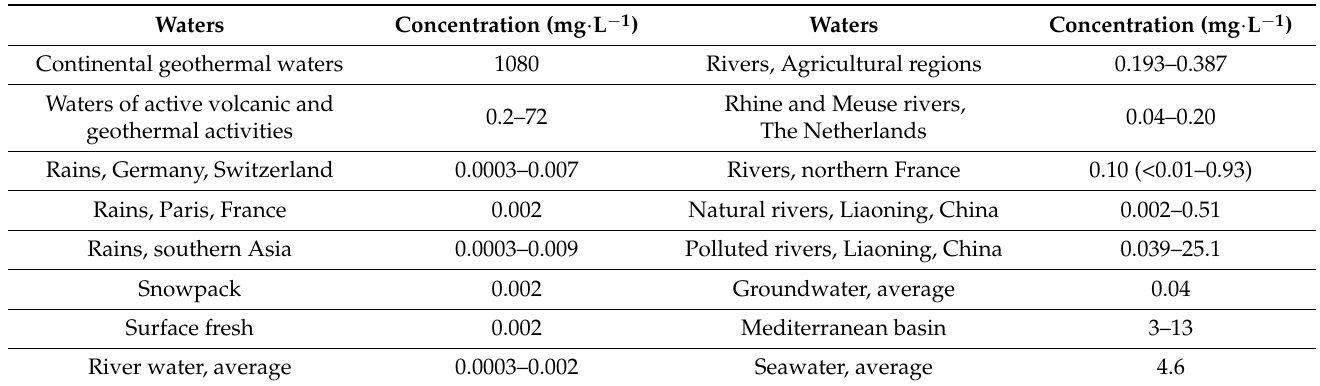
Figure 1. Various sources of boron contamination in water (reproduced from [10]). Table 1. Content of boron in natural and contaminated waters (reproduced based on